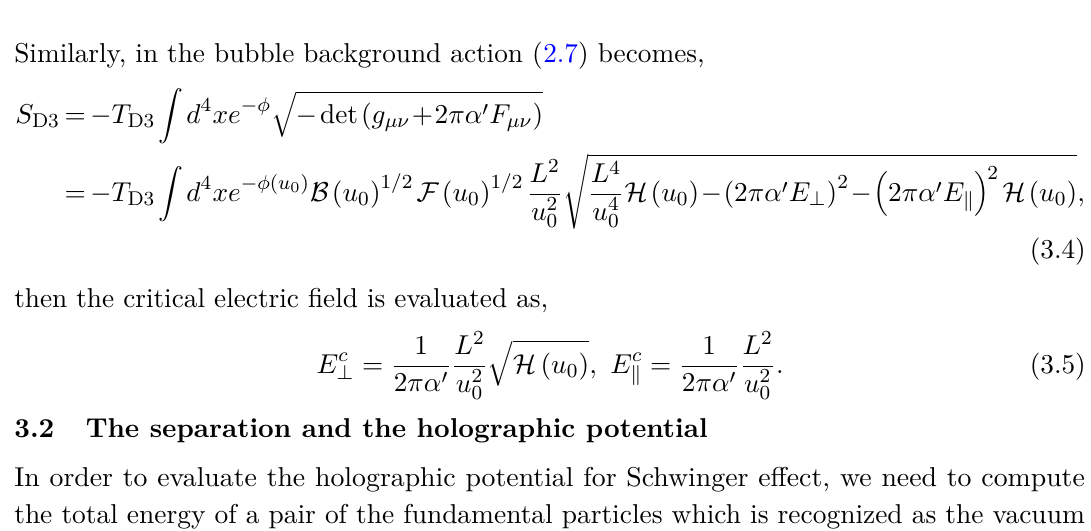
Figure 1 . A fundamental string stretched in the (denoted by the red line) plane respectively. The green line refers to the N D7 dissolved D7-branes in the